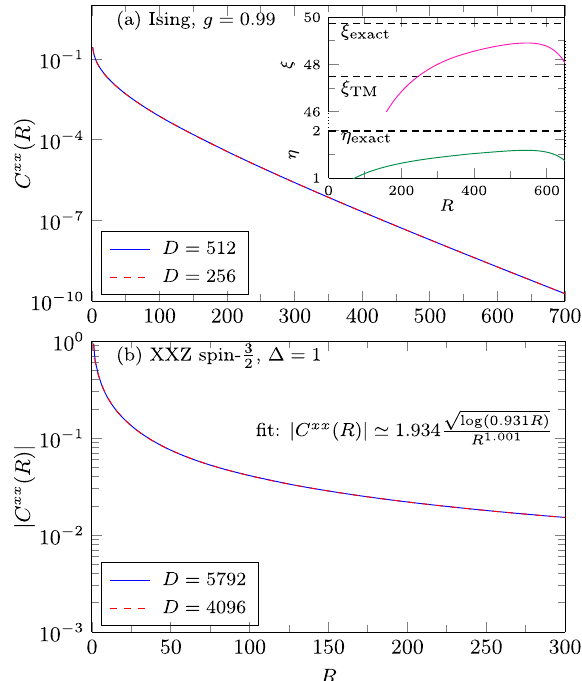
FIG. 11. (a) Example of direct fitting of the correlation function asymptotics from Eq. (2) for the Ising model in the ferromagnetic r Þ ≃ a þ r= ξ − phase, g ¼ 0 . 99 . The results of the fit ln C xx ð η ln ð r Þ for windows of r ∈ ½ R − 25 ; R þ 25 (cid:2) are shown in the inset. Extracting the actual correlation function asymptotic is substandard in this case. For comparison, in (b) we show the correlation function for the critical antiferromagnetic Heisenberg spin- 3 = 2 chain, which can be very well fitted with the theoretical scaling prediction. The fit was done for R ∈ ½ 100 ; 300 (cid:2)